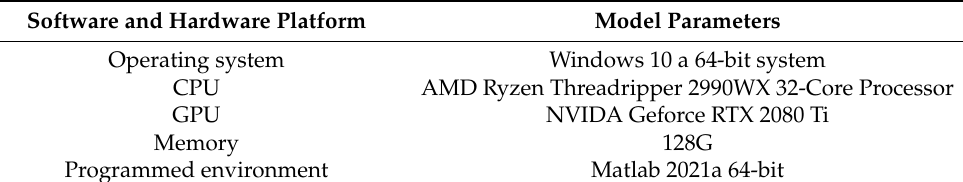
Table 2. Computer platform and environment configuration.